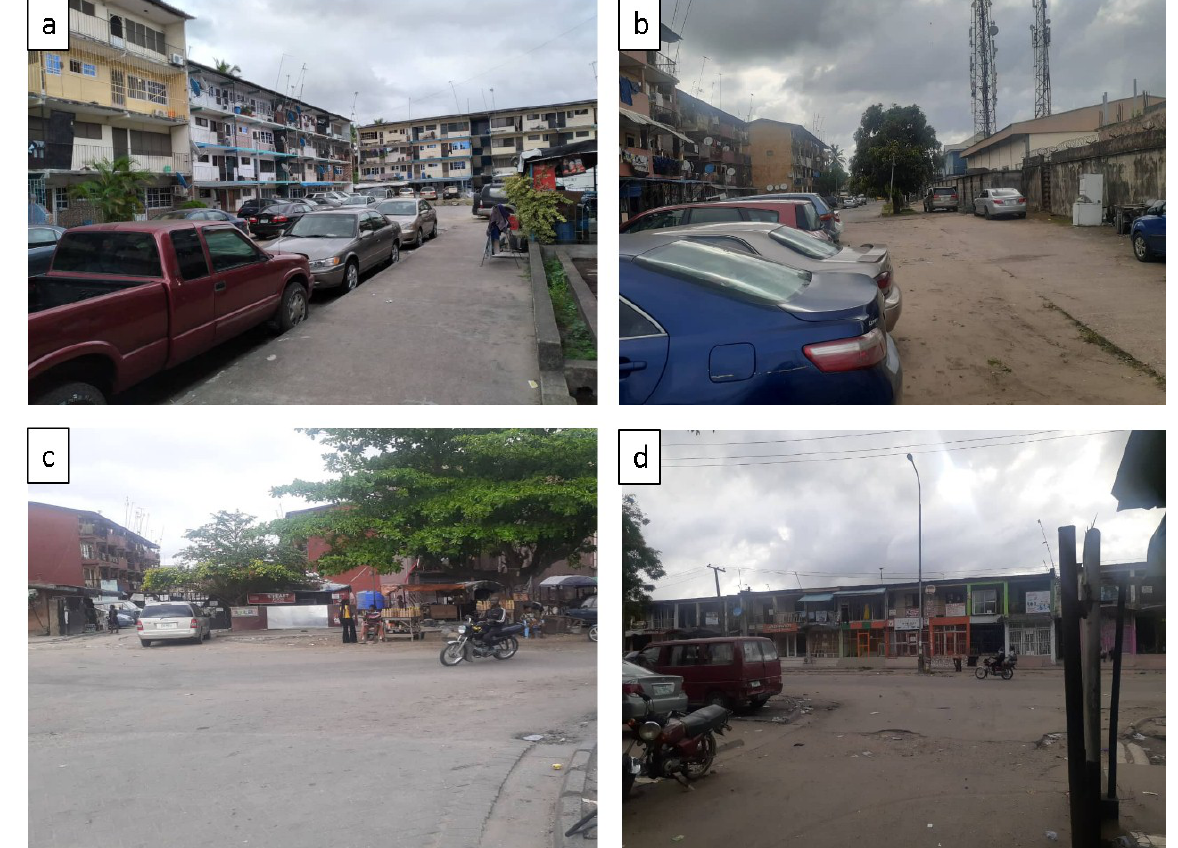
Figure 3: View of some observation stations (a) Station 5 (b) Station 1 (c) Station 3 and (d) Station